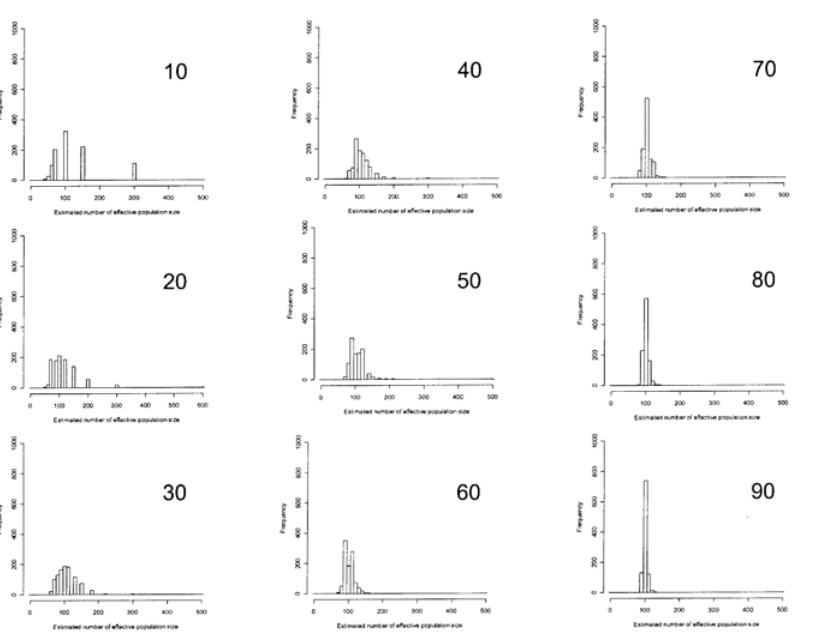
Fig. 4 The histograms of the estimated effective population size using two sample sets which are 10, 20, 30, 40, 50, 60, 70, 80, 90 individuals from the first generation and the 30 individuals from the second generation in computer simulations. The upper right number of each graph is the number of samples of the first